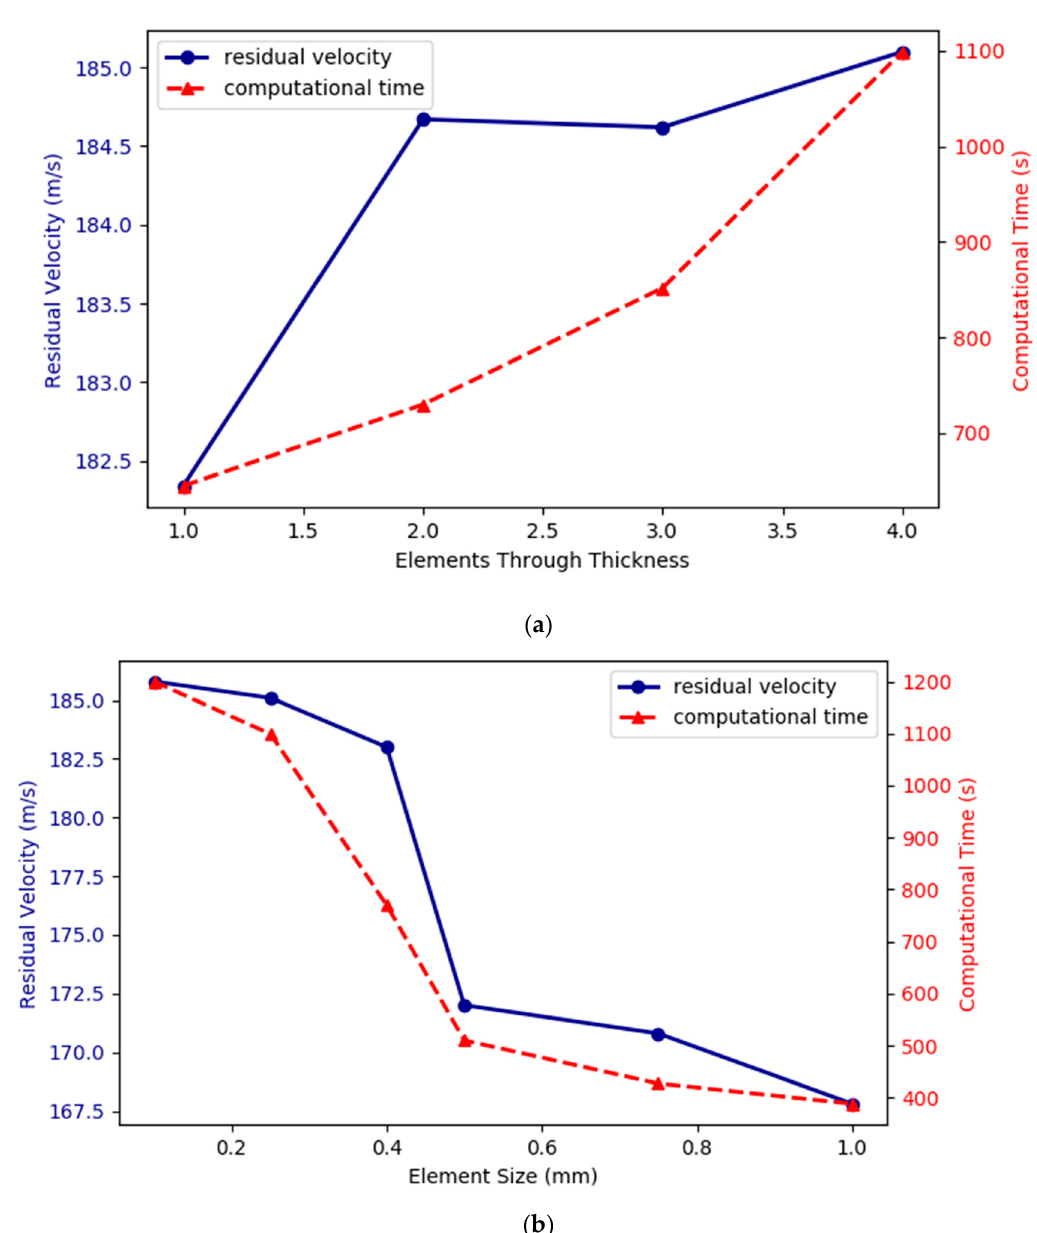
Figure 11. Mesh sensitivity for: ( a ) the number of elements in the thickness direction; ( b ) element size. The steel frame was meshed using hexahedral elements with reduced integration with 68,850 elements and 77,972 nodes. Each part was meshed using hexahedral elements with reduced integration. The mesh detail is shown in Figure 12.